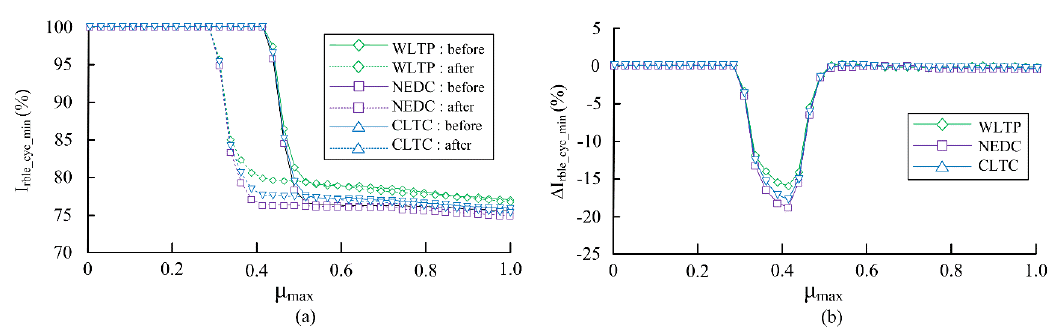
Figure 15. Optimization results in three driving cycles before and after optimization: ( a ) I rble_cyc and ( b ) ∆ I rble_cyc .